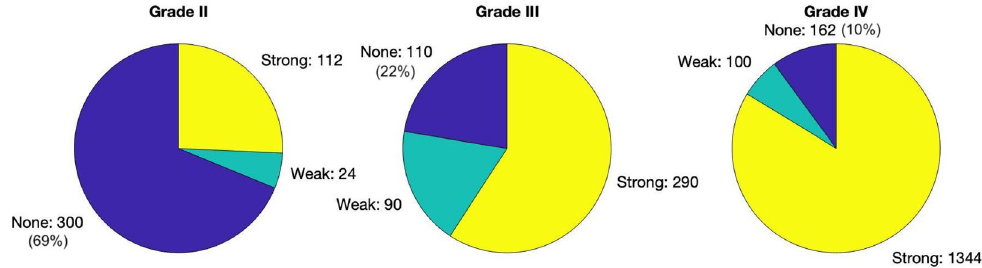
Figure 1. Fluorescence visibility during surgery versus WHO Grade. The WHO Grade I tissues all showed no visible fluorescence. Fluorescence categorized as strong (yellow), weak (green), not visible (blue). The number of measured tissues is given for each